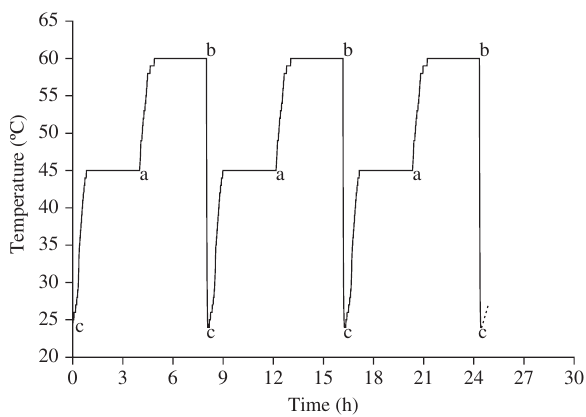
Figure 2 Evolution of the temperature during the weathering tests (a, beginning of the UV step; b, beginning of the spray step; c, begin- ning of the condensation step).